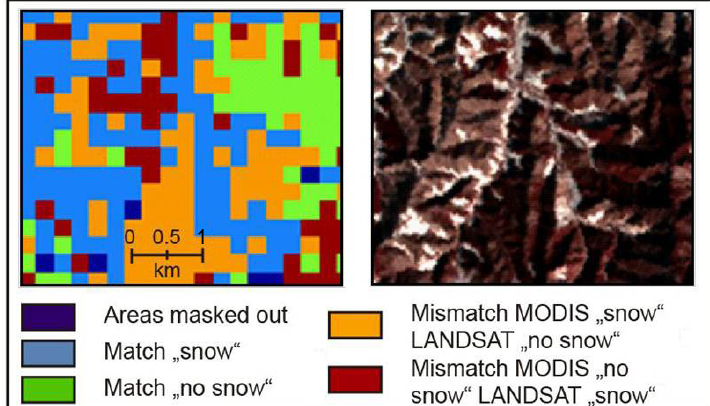
Figure 6. Orange areas in the mismatch map (left) indicate a, probably correct, classification of the land surface as “snow” in areas where low illumination conditions (compare Landsat image on the right) limit the detection ability of the Landsat